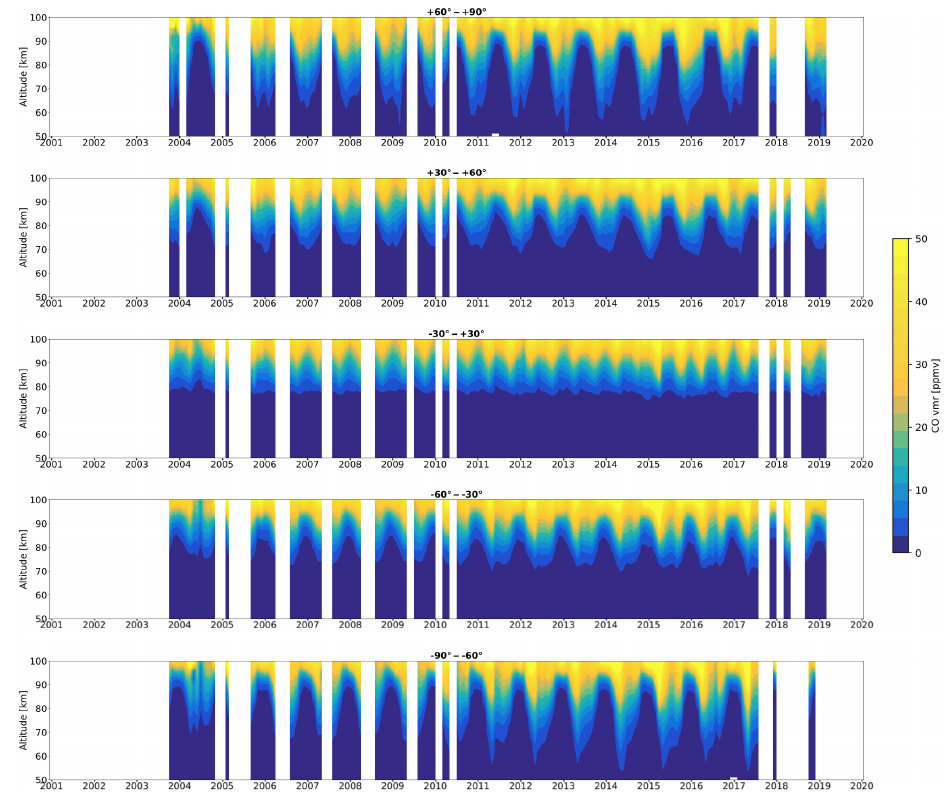
Figure 8. Time series of CO volume mixing ratios measured by SMR for different latitude bands. The white bands indicate periods during which the number of scans in the given latitude band is lower than 10. The ticks on the x axis correspond to the beginning of each year. Table 2. Characteristics of the MIPAS CO datasets used for comparison. Vertical resolutions refer to the observations in the altitude range 50–100km considered in this